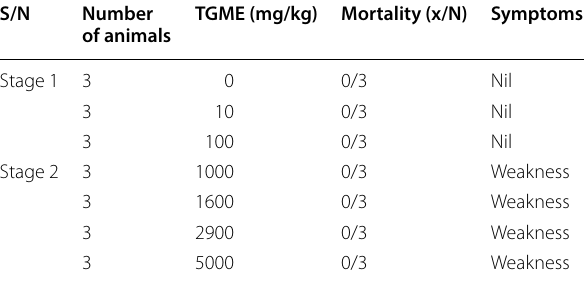
LD50 greater than 5000 mg/kg b.w